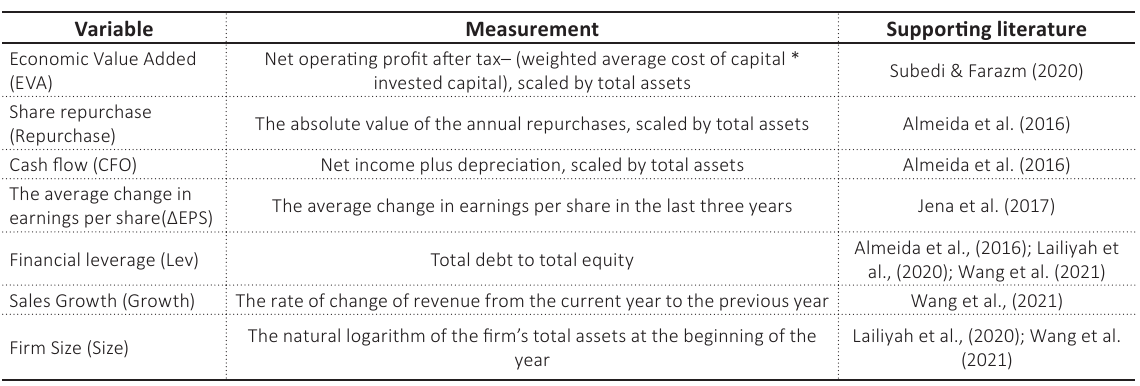
Table 2. Measurement of the